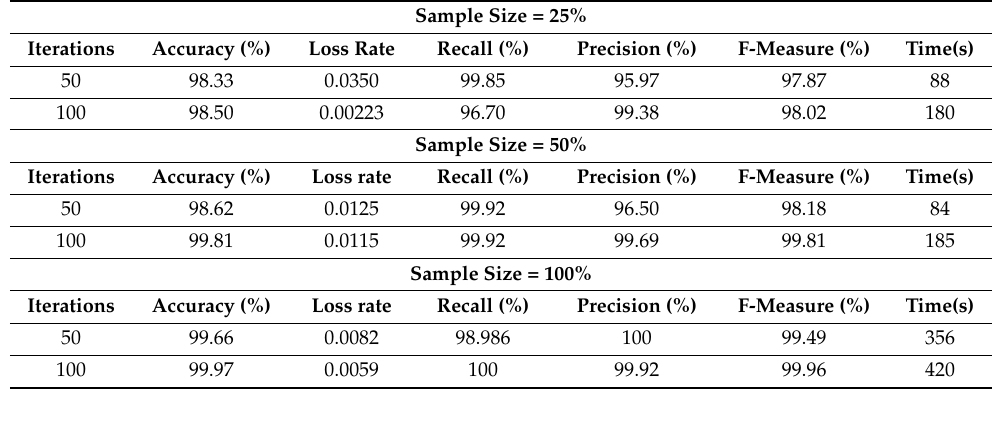
Table 11. Experimental results of the dataset with different sample sizes.